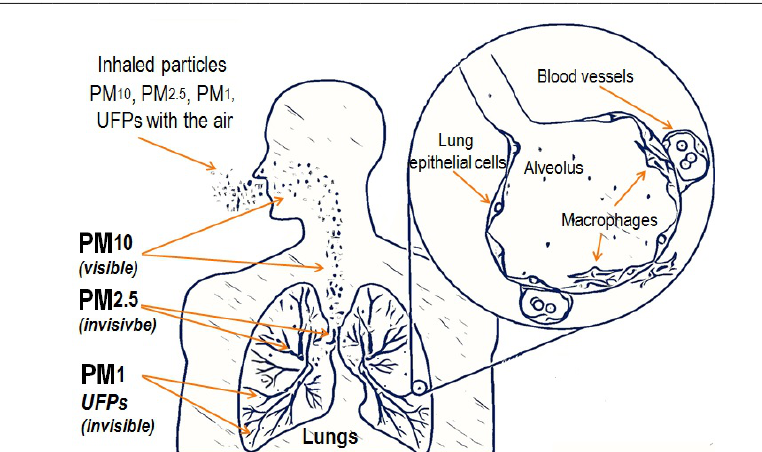
Fig. 1. How deep the inhaled particles get in the alveolar structures of the lungs (smaller than 2.5 mm (PM 2.5 ))